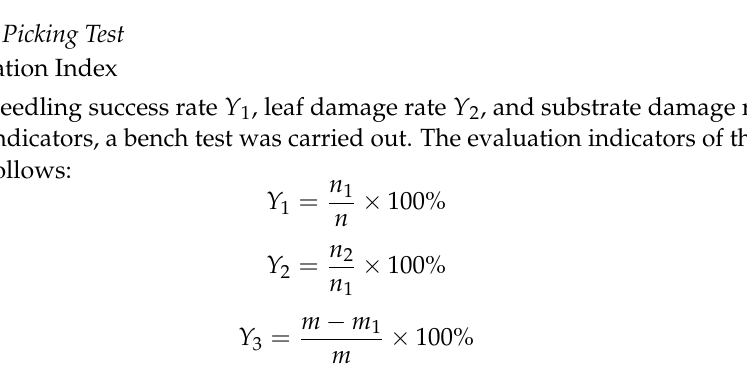
Table 4. Results of the picking test.